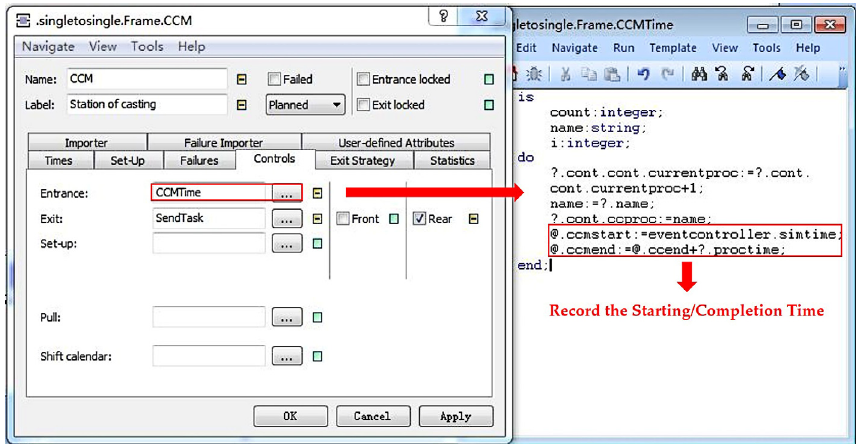
Figure 3. Record on the staring (completion) times of heats in CCM.